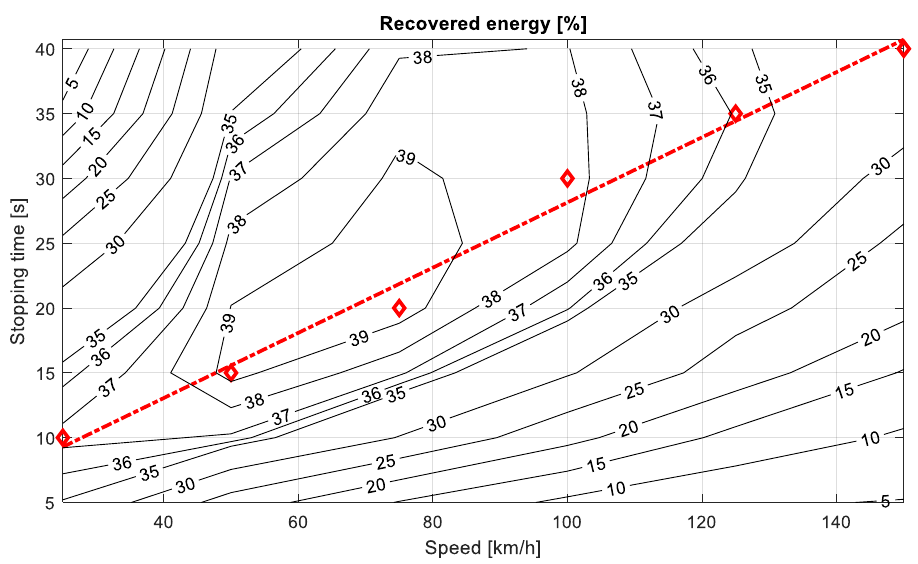
Figure 17. Contour plots of the recovered energy. Red dotted line represents the best fit of optimal conditions for each speed.